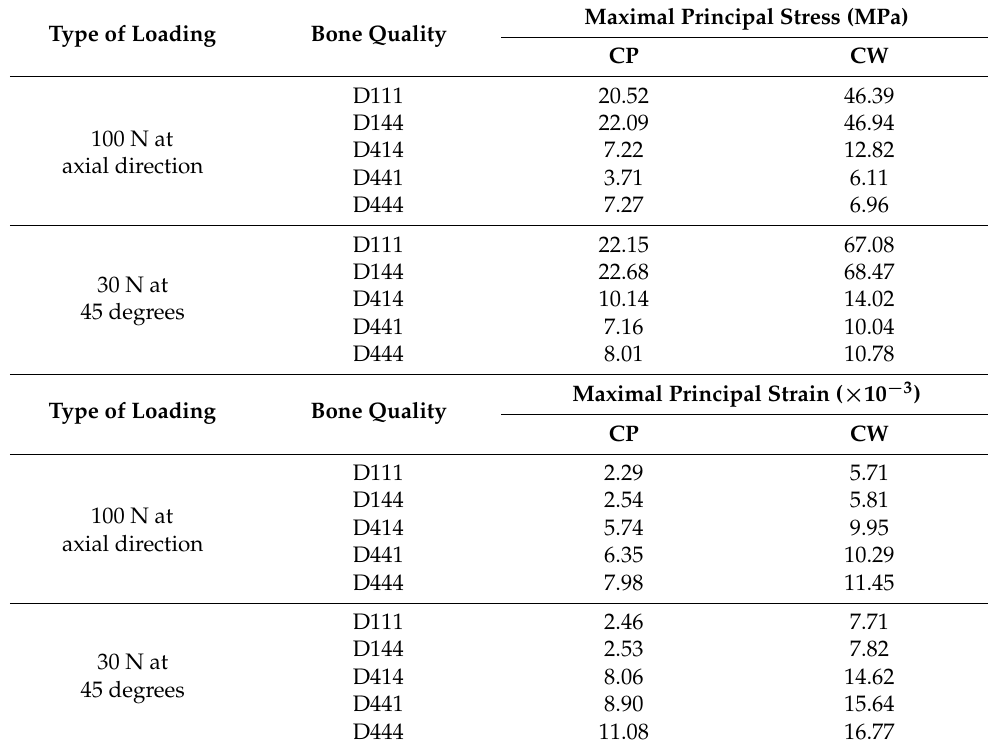
Table 4. The maximal principal stress and strain of CP and CW in fi ve bone-quality conditions.